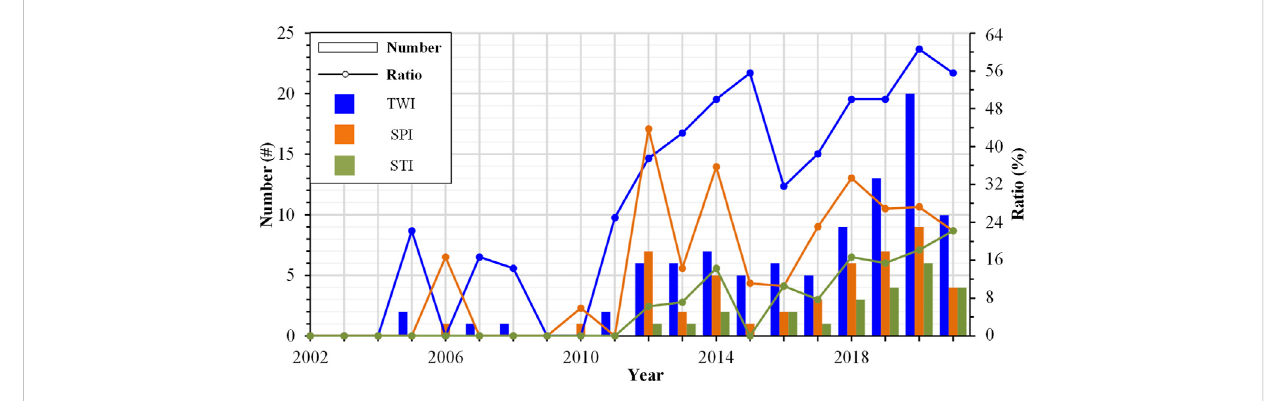
FIGURE 4 Application of composite hydrological